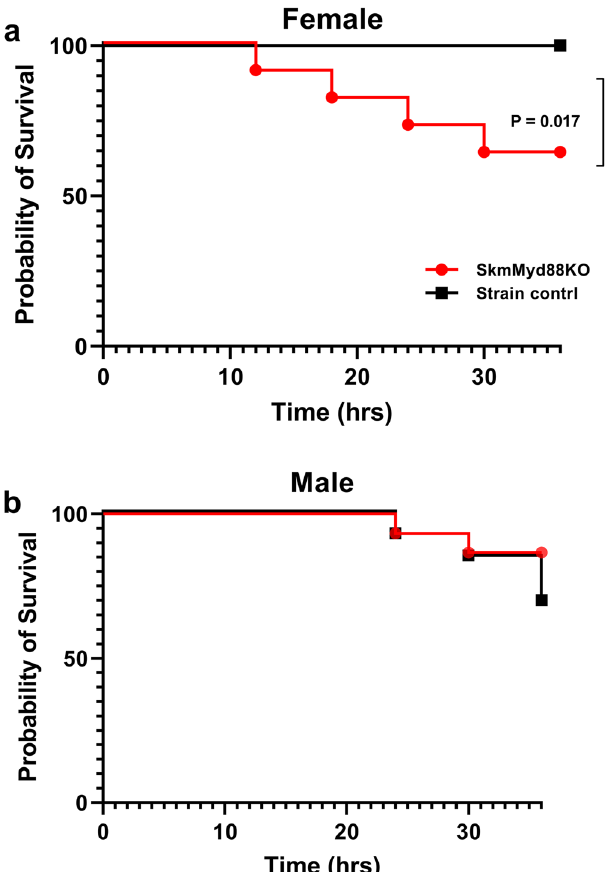
Figure 6. Mortality rates for male and female skmMyd88KO mice compared to strain matched controls. Five day mortality was predicted based on xiphoid temperature measurements at 36 h, as described previously 15 . N = 12 mice per group. P value = Kaplan Meier parametric survival